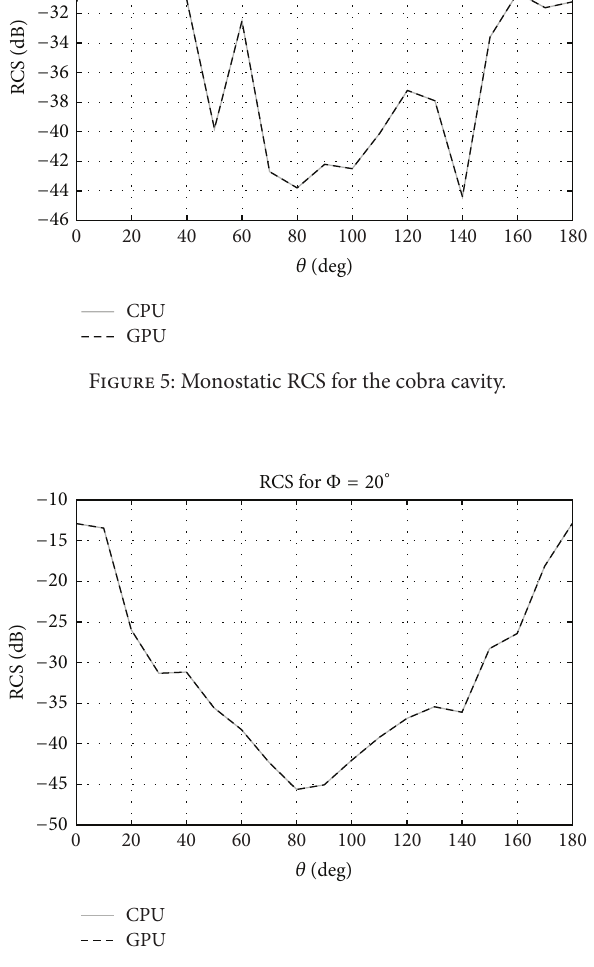
Figure 6: Monostatic RCS for the airplane.